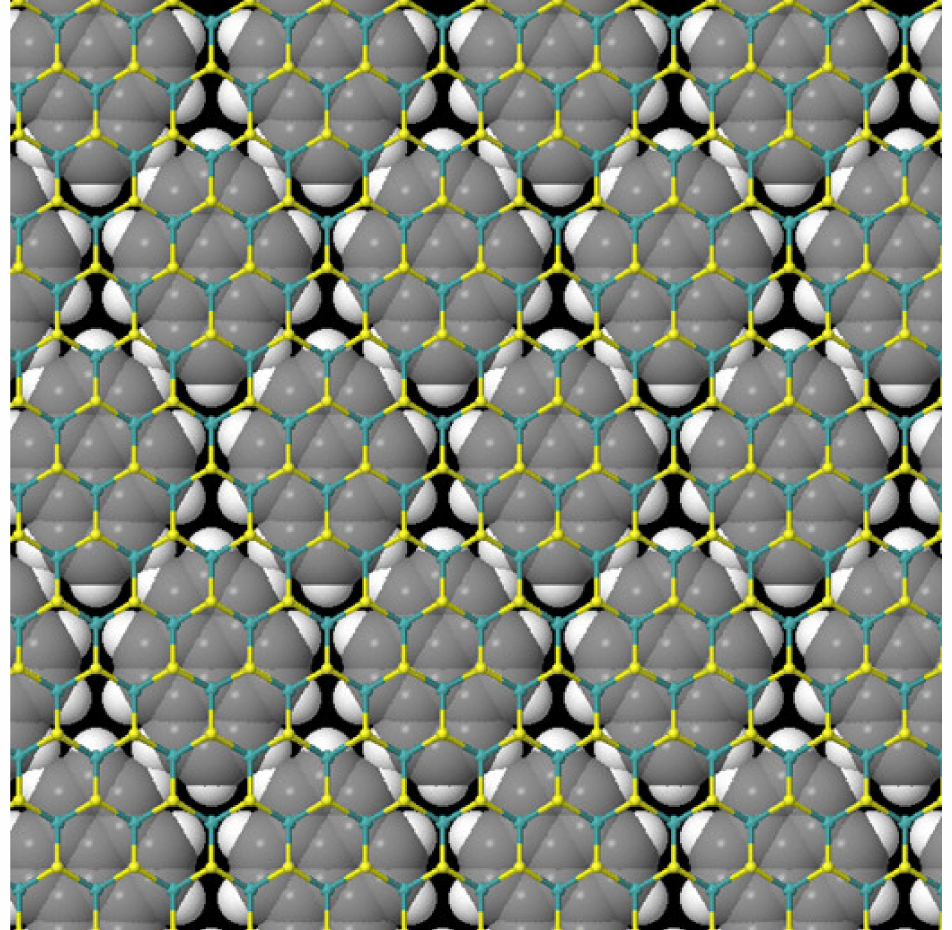
Figure 3. Calculated structure for pyrene in a MoS 2 -3 × 3 surface array at 100% surface coverage, the most stable packing configuration. Pyrene atoms are shown with atomic van der Waals radii, showing the complete surface protective layer. Experimentally we calculate pyrene is forming between two and three